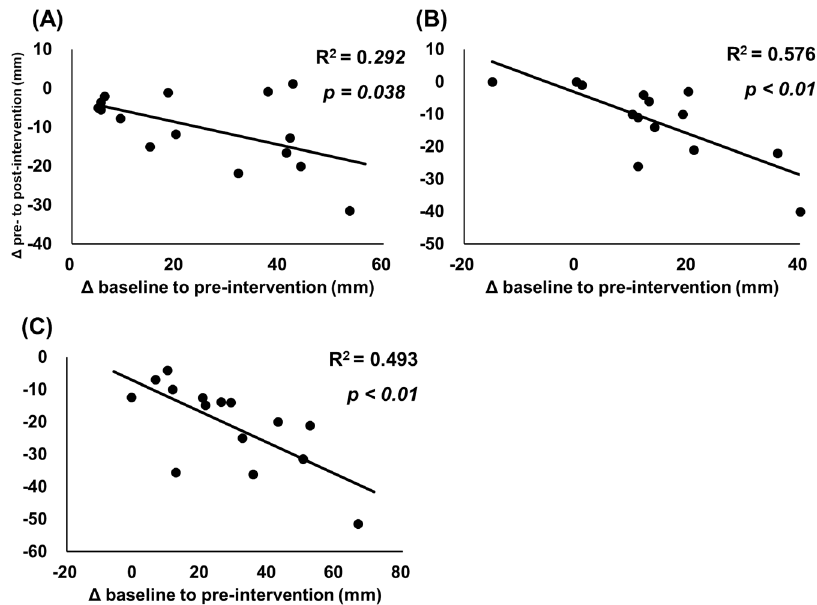
Figure 5. Relationships between changes in muscle soreness. Data presented as individual data points with R 2 and p values. The figure shows relationships between changes from baseline to pre- intervention and from pre-intervention to post-intervention in muscle soreness for muscle contrac- tion ( A ), stretching ( B ), and palpation ( C ).